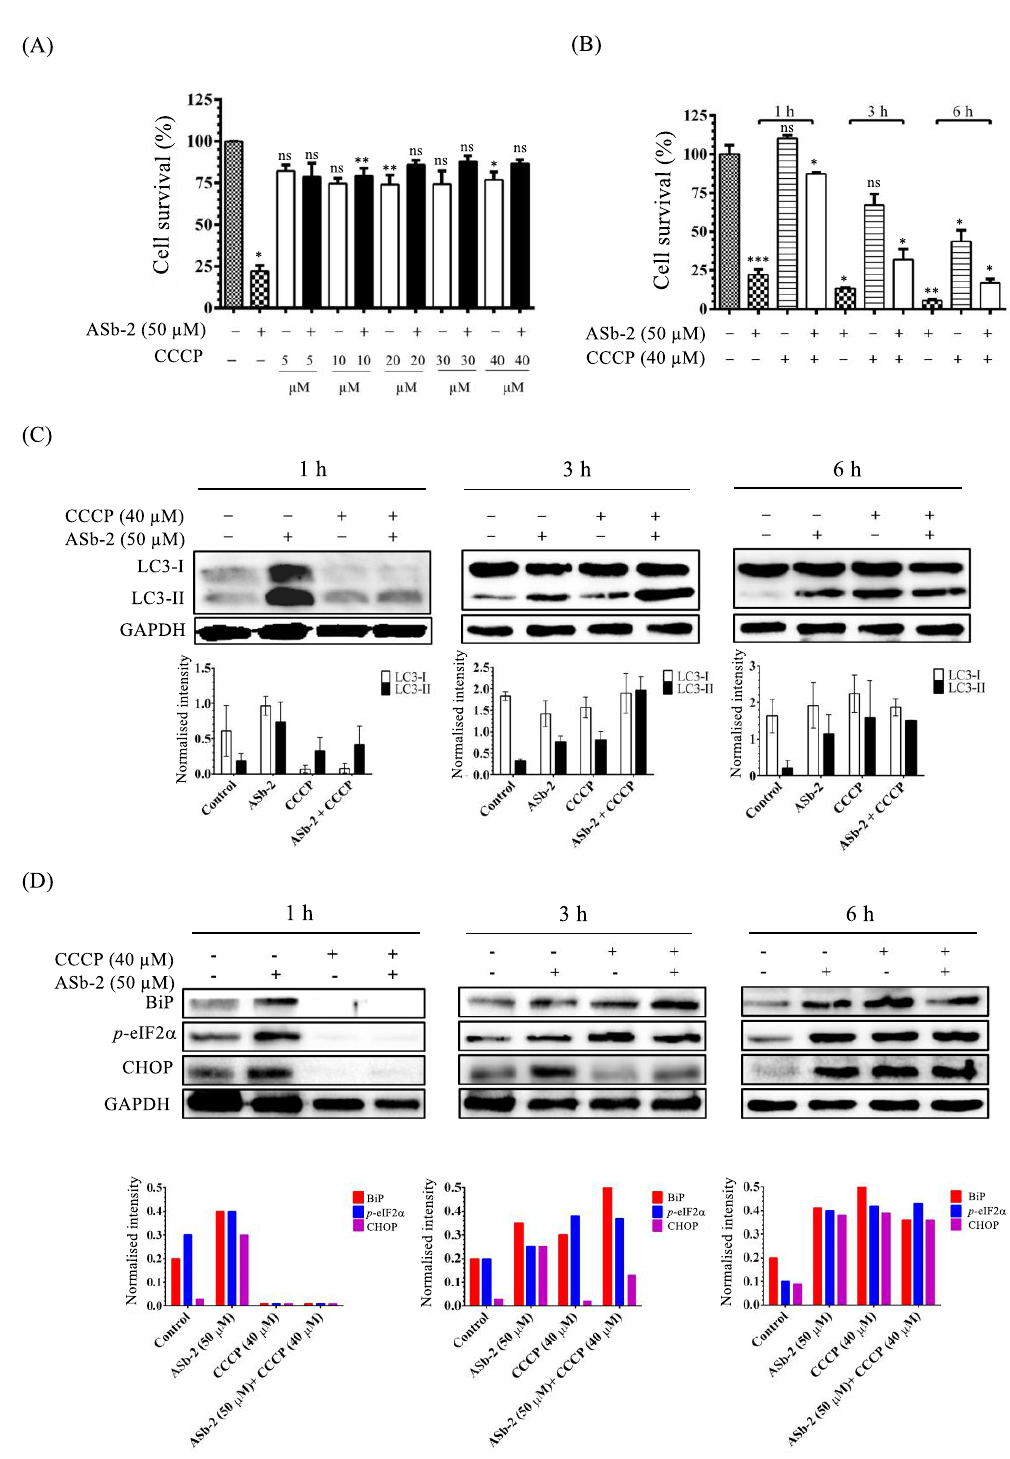
Figure 14. ( A ) The results of MTT assays of Jurkat cells treated with ASb-2 (50 µ M) in the presence of CCCP (0–40 µ M) for 1 h at 37 ◦ C. ( B ) The results of MTT assay of Jurkat cells that had been treated with ASb-2 in the presence of CCCP (40 µ M) for 1, 3, and 6 h at 37 ◦ C. ( C ) Western blot analysis of LC3-I/II expression of Jurkat cells that had been treated with ASb-2 (50 µ M) in the presence of CCCP (40 µ M) for 1, 3, and 6 h at 37 ◦ C. ( D ) Western blot analysis of BiP, p -eIF2 α and CHOP in Jurkat cells treated with ASb-2 in the presence of CCCP for 1, 3, and 6 h at 37 ◦ C. * p < 0.05, ** p < 0.01, and *** p < 0.001 indicate the significant differences from the control. ns: no significant ( the statistical data in Figure 14A,B are listed in Table S5 in the Supporting Information) .